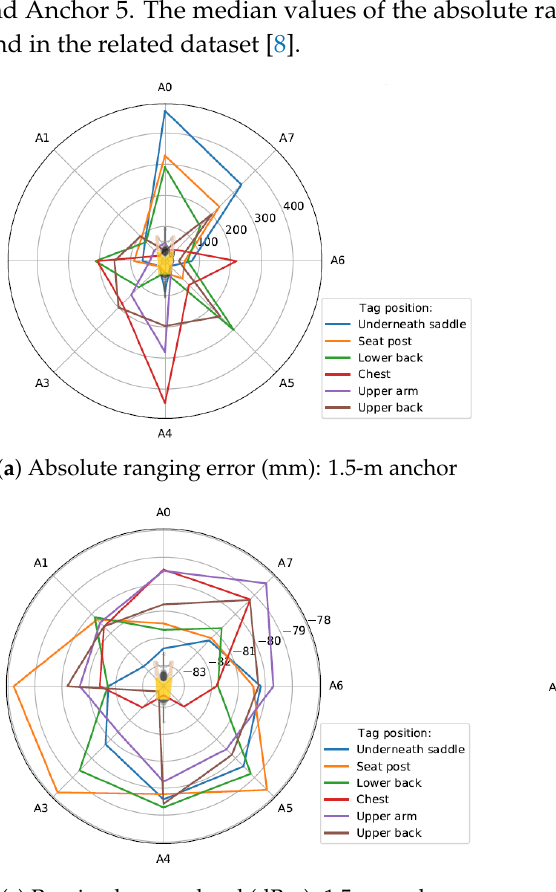
Figure 7. Results tests: track bike.